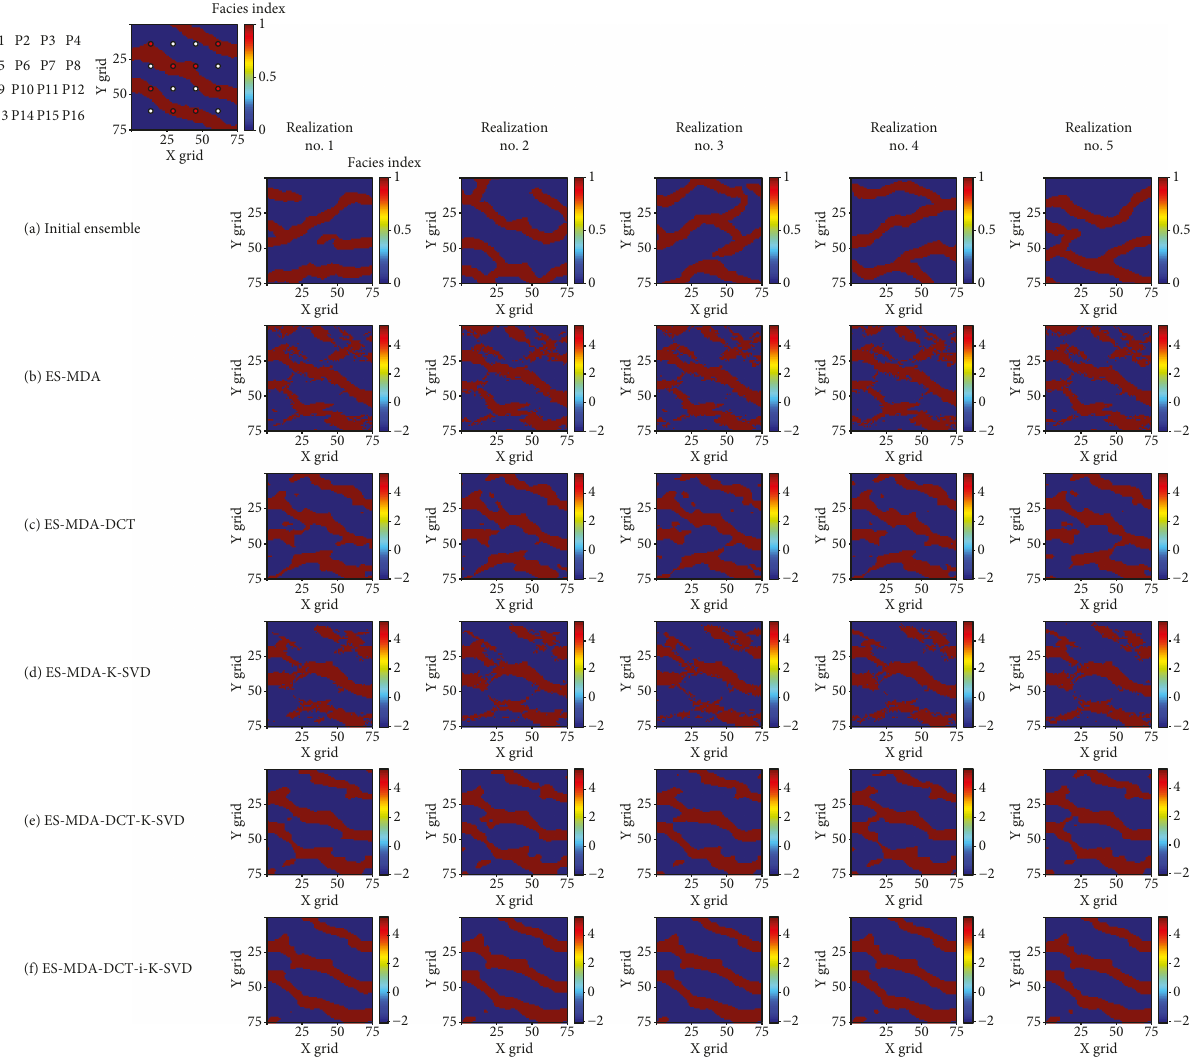
Figure 16: Permeability distribution of fi ve quali fi ed reservoir models obtained after history matching of Case